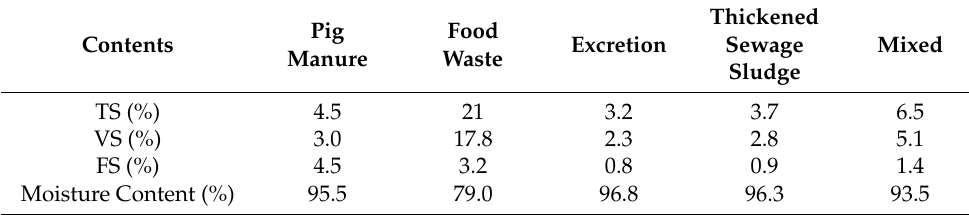
Table 4. Characteristics of organic